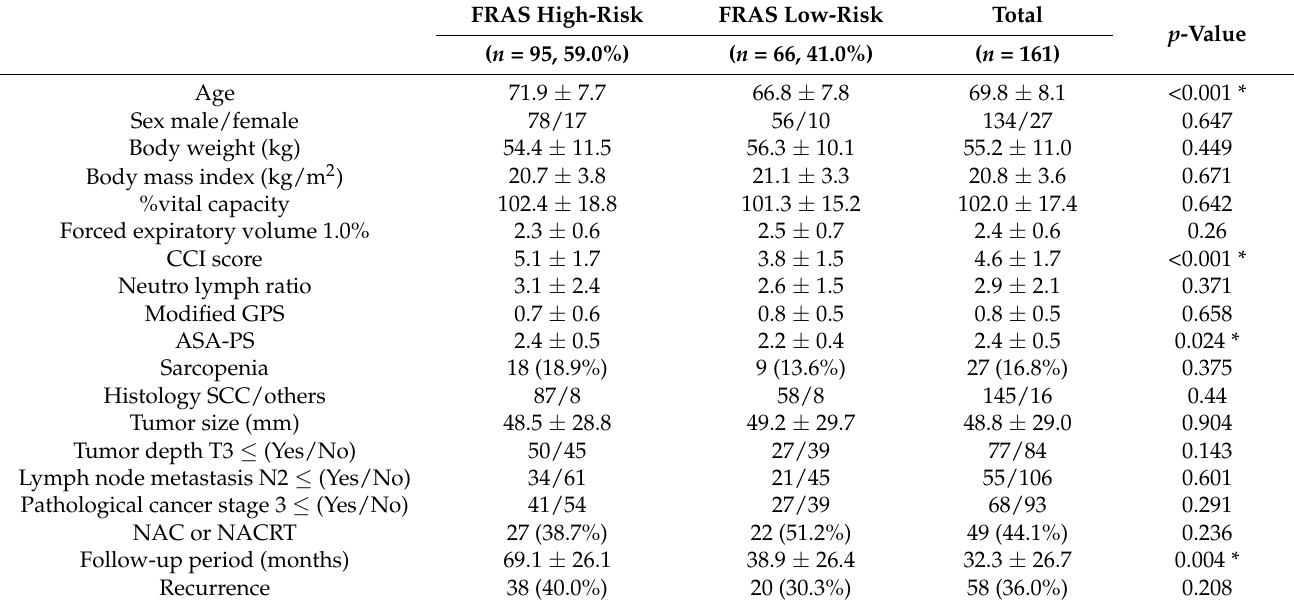
Table 2. Patients’ clinicopathological